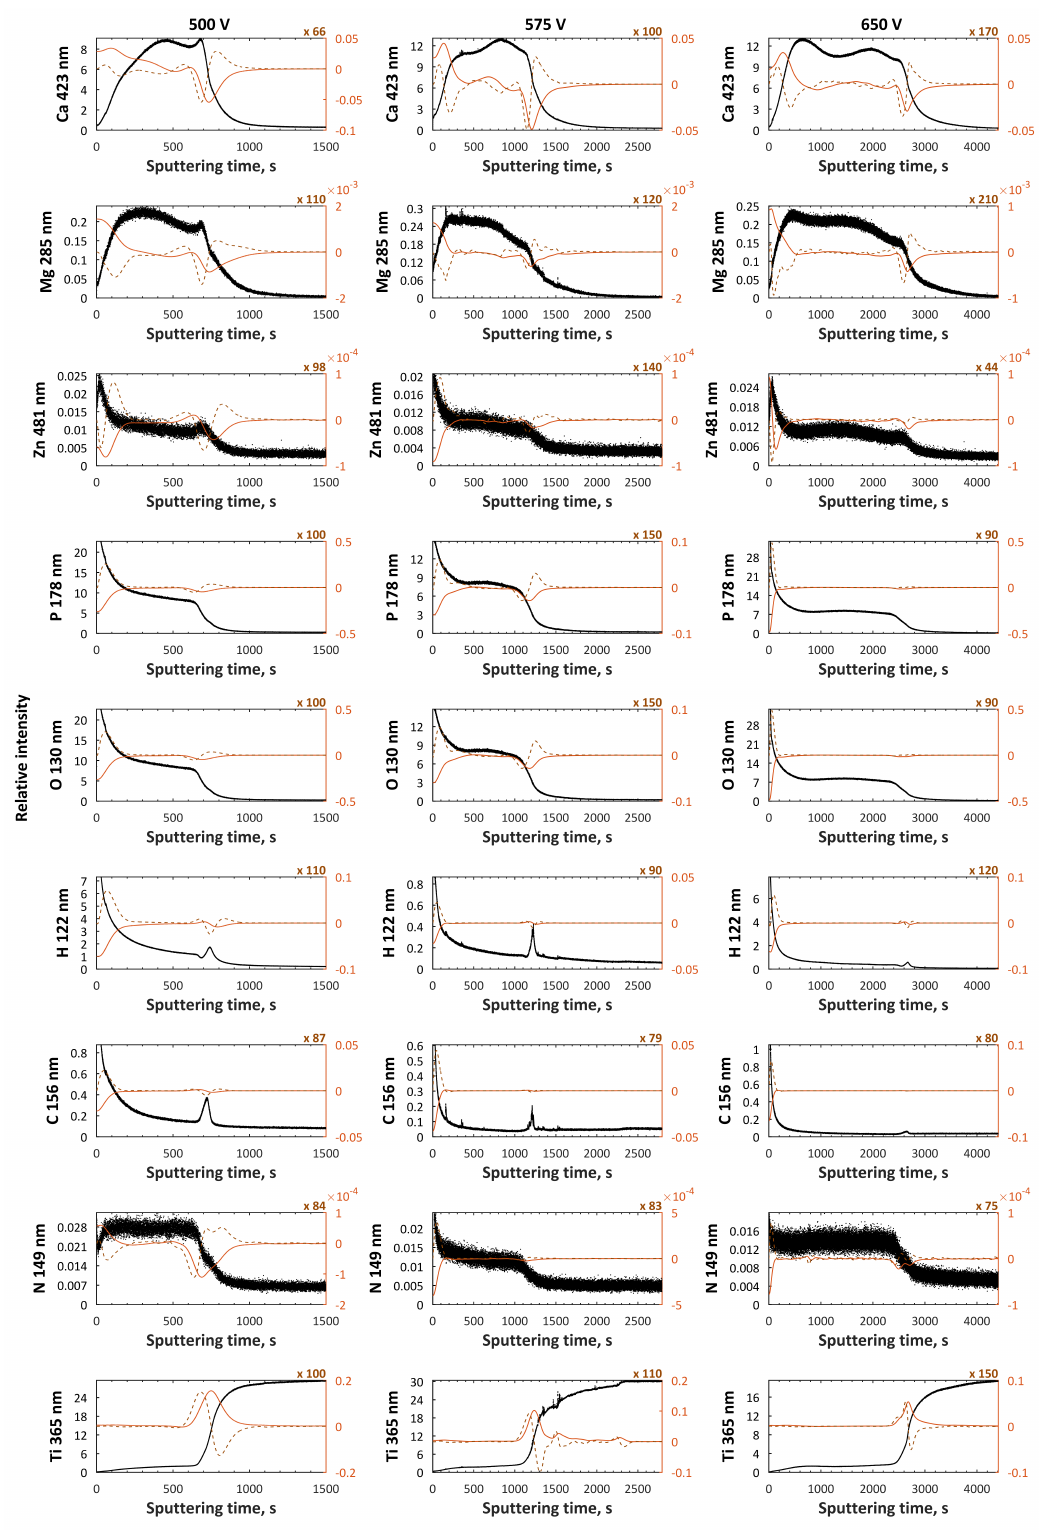
Figure 5. GDEOS signals (black), first derivatives (red continuous line), and second derivatives (brown dashed line) for samples formed in Electrolyte